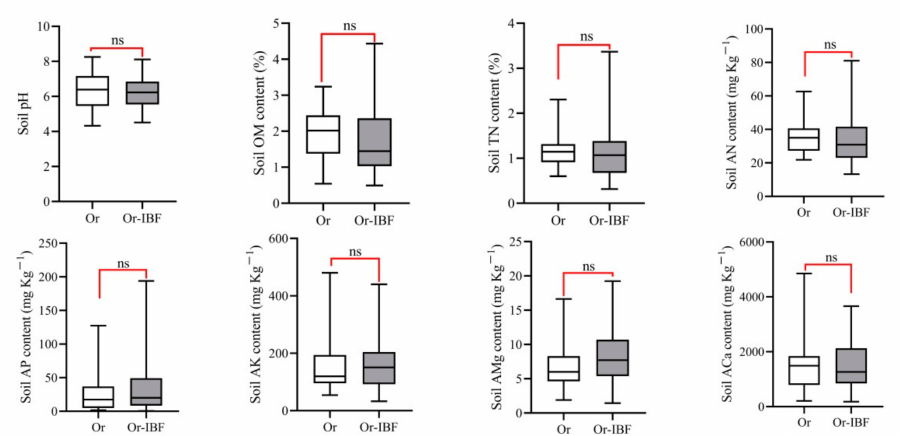
Figure 11. Box plots of soil pH and mineral nutrient contents in the orchard with and without IFB fruit. Or and Or-IBF represent 24 mango orchards without IFB fruit and 76 mango orchards with IFB fruit, respectively. OM: organic matter, TN: total N, AN: available N, AP: available P, AK: available K, AMg: available Mg, ACa: available Ca. Significant differences were determined by one-way ANOVA test: ns, no significant difference.